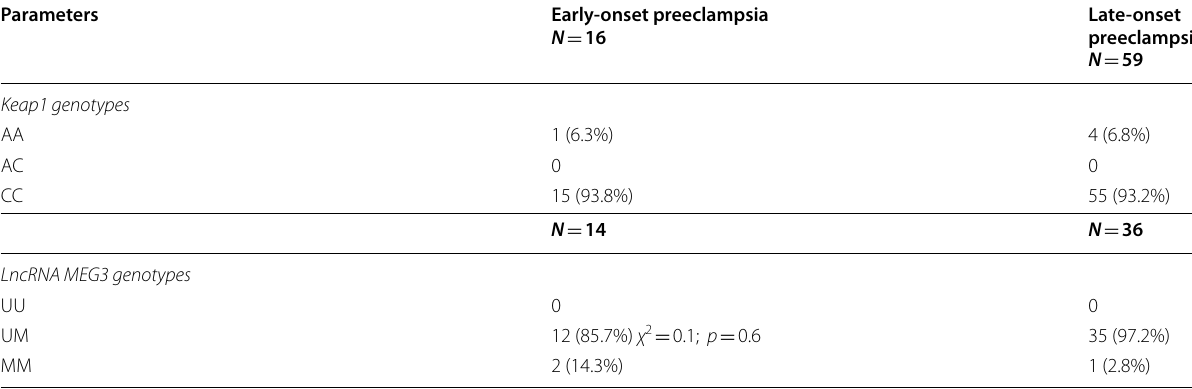
Table 3 Distribution of Keap1 and lncRNA MEG3 genotypes in early-onset and late-onset